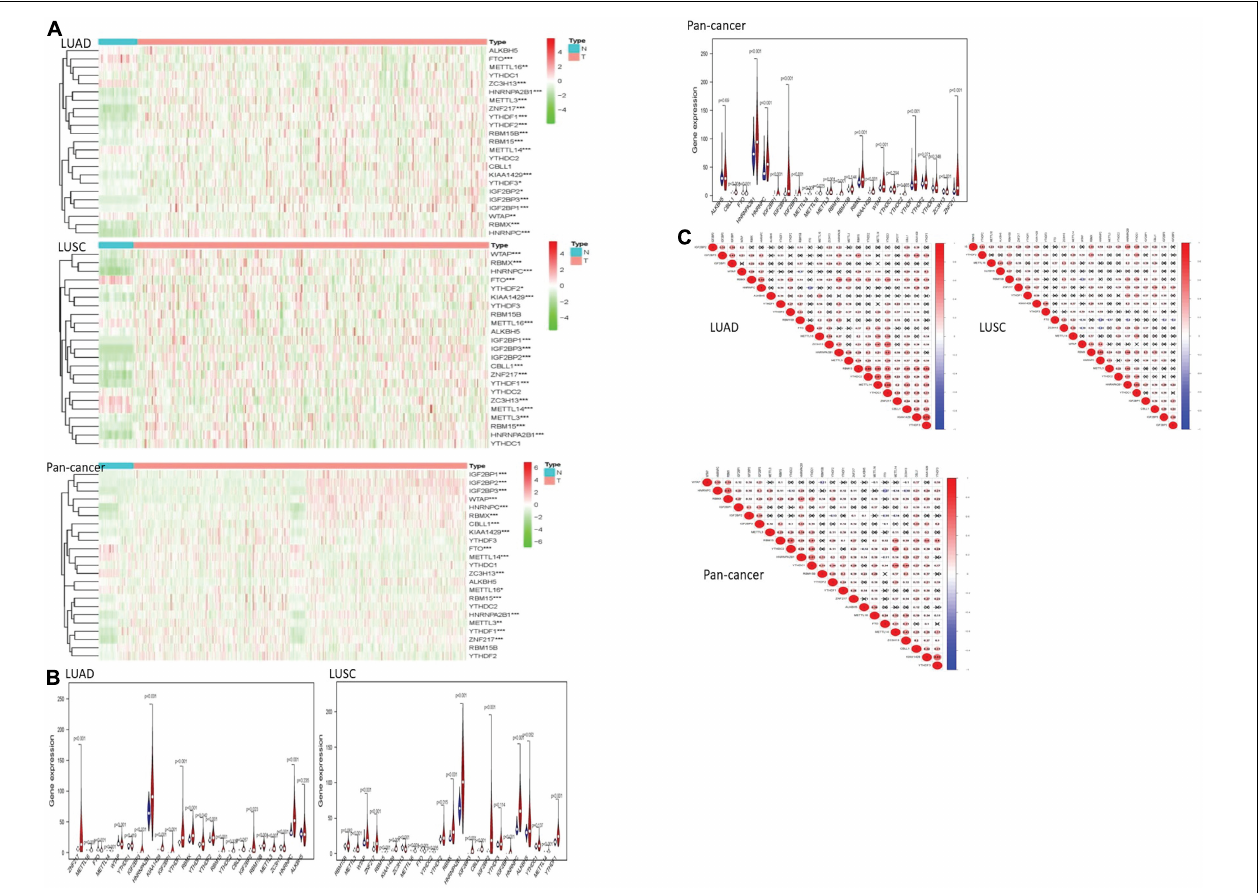
FIGURE 1 | The overview of m 6 A RNA methylation regulators in lung cancer. (A) The figures reflect the expression levels of 23 m 6 A RNA methylation regulators in normal tissues and lung cancer tissues. When the gene expression level is high, the color turns red in the picture. However, the color becomes green with the gene expression decreasing. (B) The tree diagram at the top of the figure represents the clustering results of different samples from different experimental groups, and the tree diagram on the left demonstrates the clustering results of different genes from different samples. The “vioplots” clearly show the difference between m 6 A RNA methylation regulators in lung cancer and normal lung tissue. Blue represents normal lung tissue, and red represents lung cancer. (C) The diagram visually shows the relationship between different m 6 A RNA methylation regulators through Pearson correlation analysis. Red represents a positive correlation, and blue represents a negative correlation. * P < 0.05, ** P < 0.01 and *** P < 0.01.